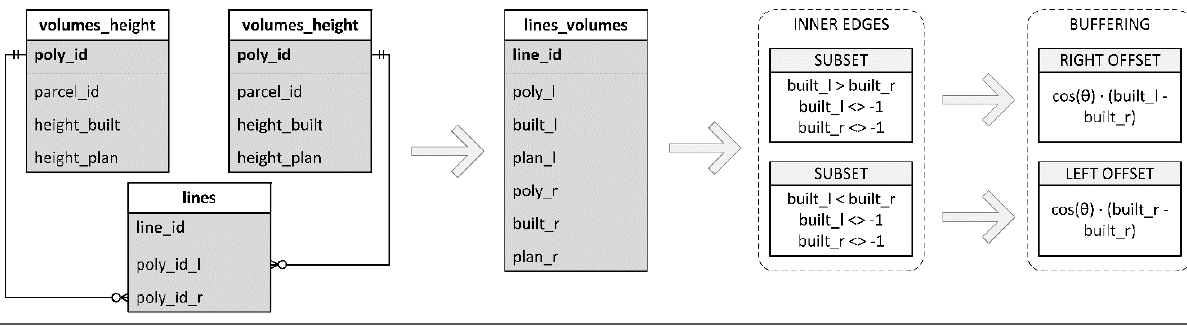
Figure 9. Diagram of the method to project the relative height onto lower